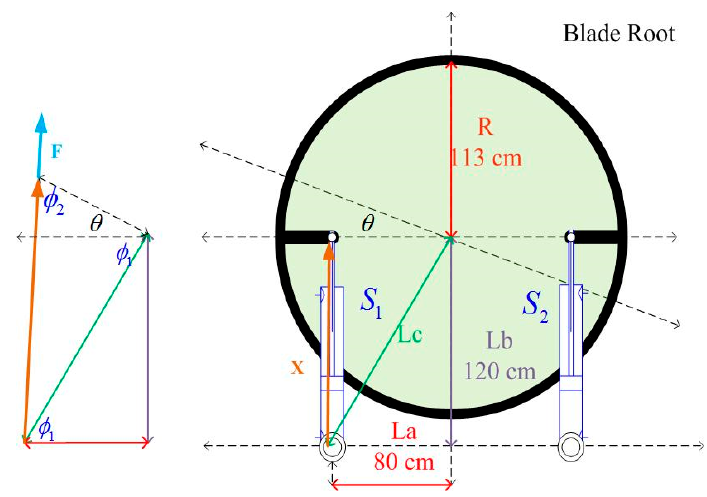
Figure 4. Geometric relation of mechanism for driving system.